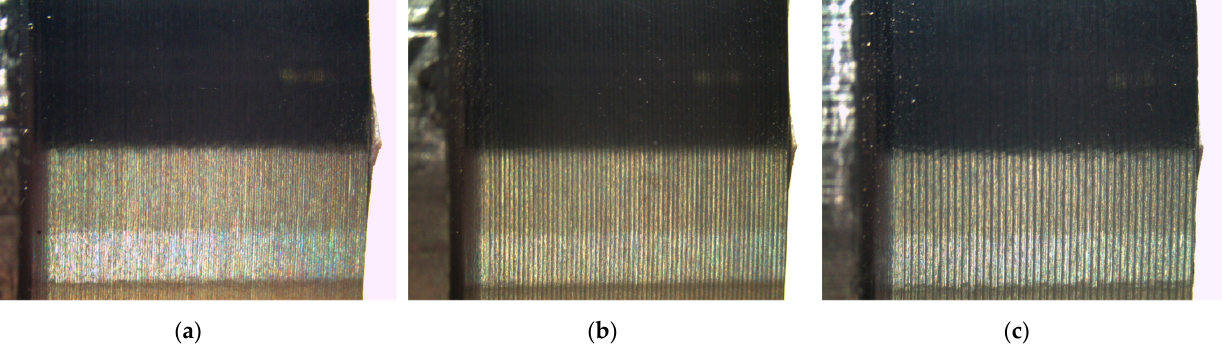
Figure 14. Micrographs taken of some of the machined specimens from the tool feed rate tests using the tool CT-f5: ( a ) for the test at 0.08 mm/rev; ( b ) for the test at 0.16 mm/rev; ( c ) for the test at 0.24 mm/rev.